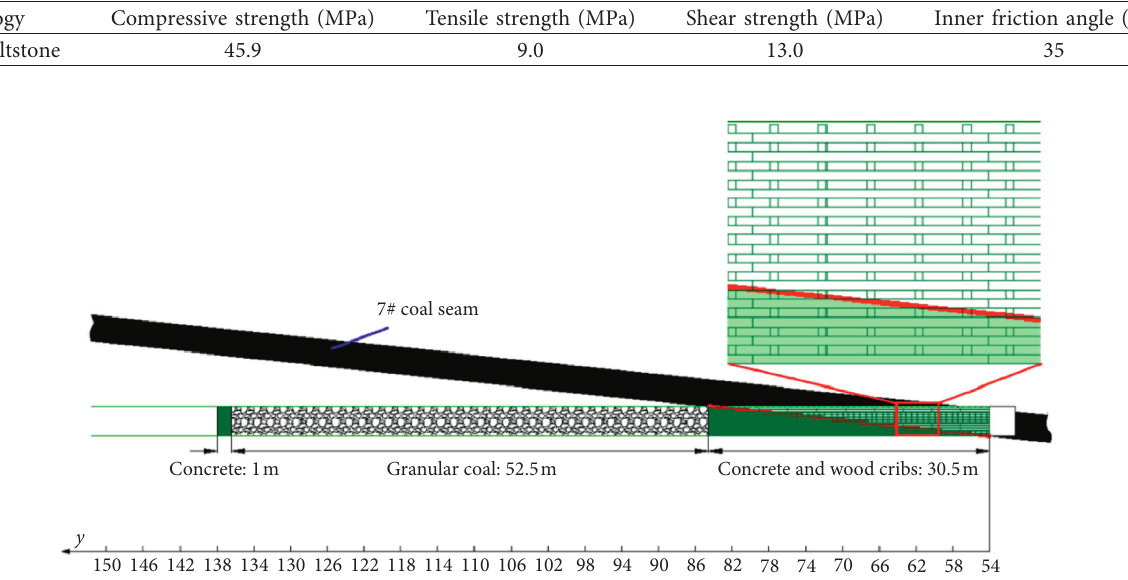
Figure 7: No. 7118 cross-cut supporting design.